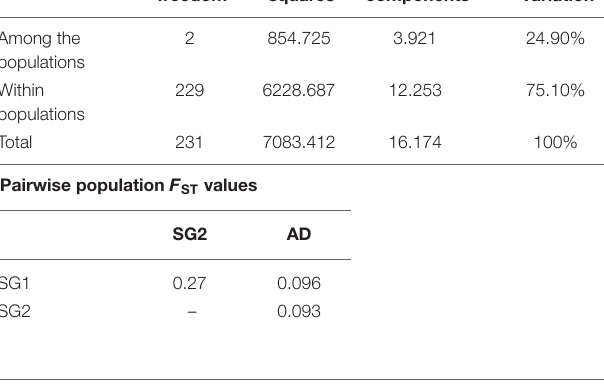
genes are losing their effectiveness to blast disease (Das et al., 2012).